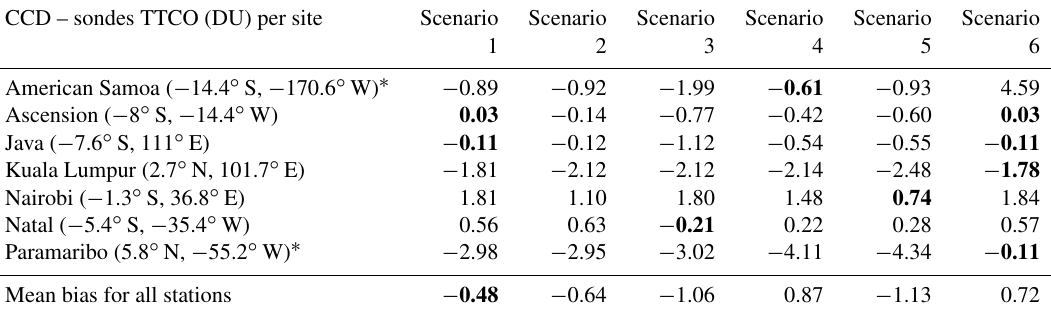
Table 1. Mean differences (in DU) between merged TTCO data, retrieved with the CCD method using six possible harmonisation scenarios, with integrated ozone columns up to 200hPa from nine SHADOZ stations. The stations marked with an asterisk ( ∗ ) present data from the newest reprocessed (V05.1_R) version (Thompson et al., 2007; Witte, 2017). The regions where the merged scenarios have the smallest biases with the ozonesondes are marked with bold. Scenario 1 has the smallest mean bias for all the stations. CCD – sondes TTCO (DU) per site Scenario Scenario Scenario Scenario Scenario Scenario 1 2 3 4 5